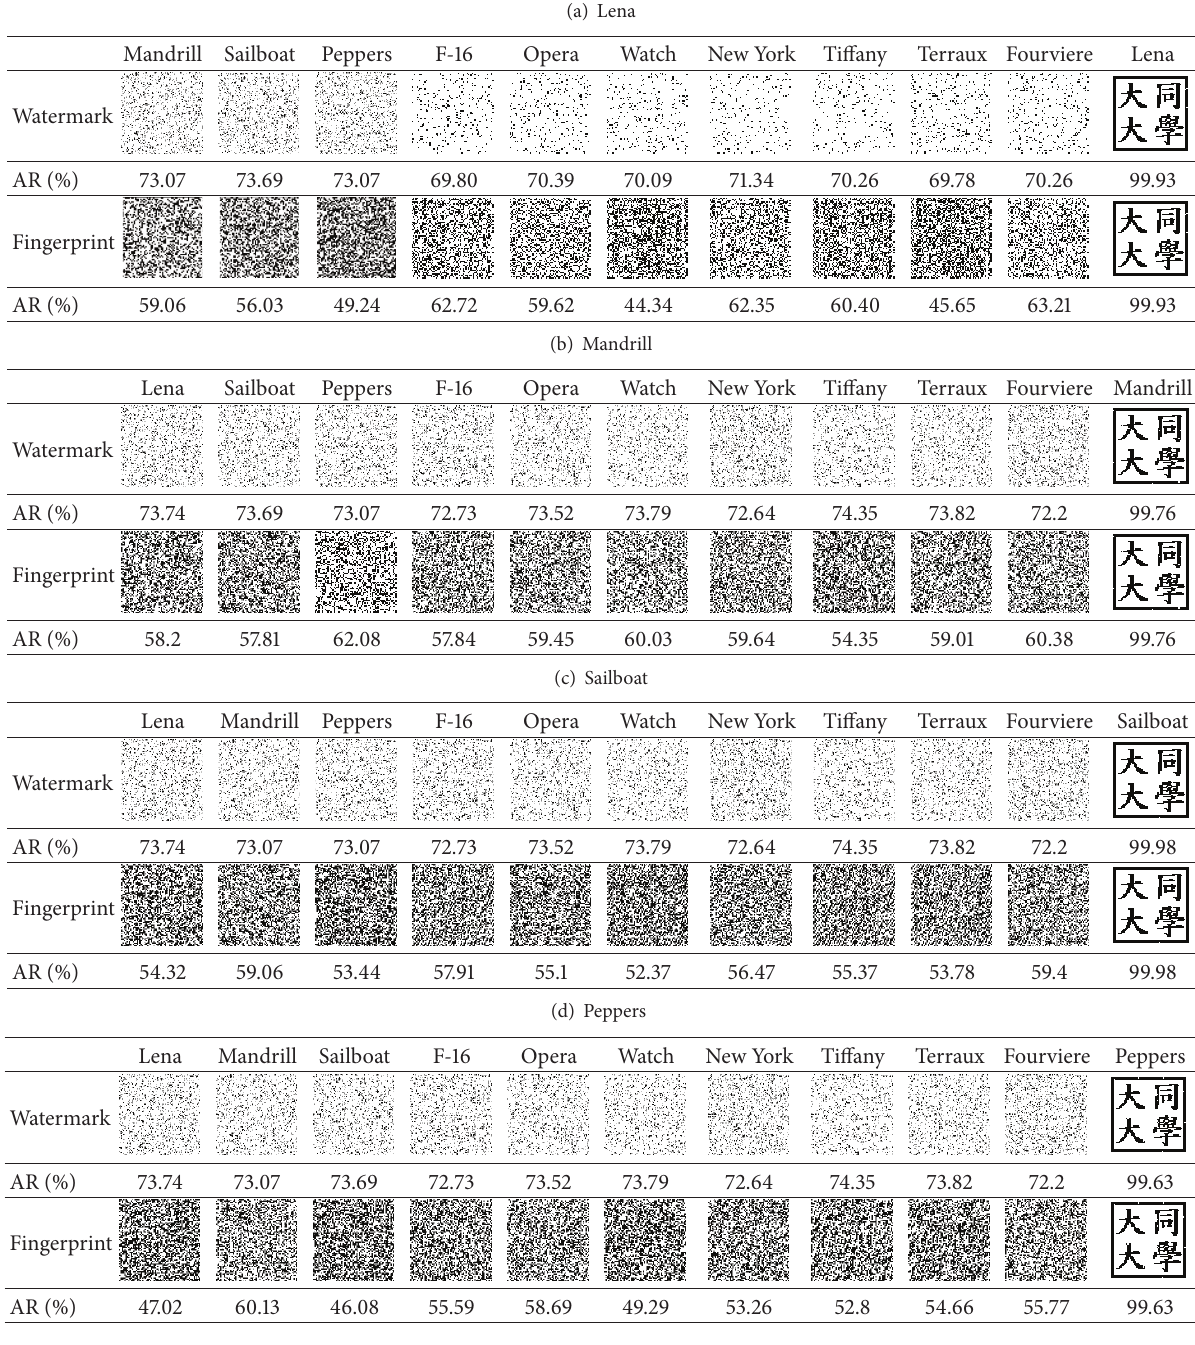
Table 4: Experimental results of the uniqueness